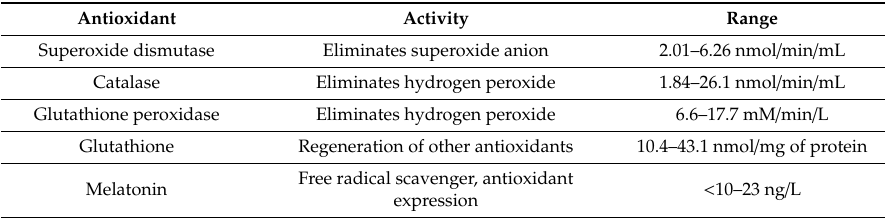
Table 2. Endogenous antioxidants in breastmilk.